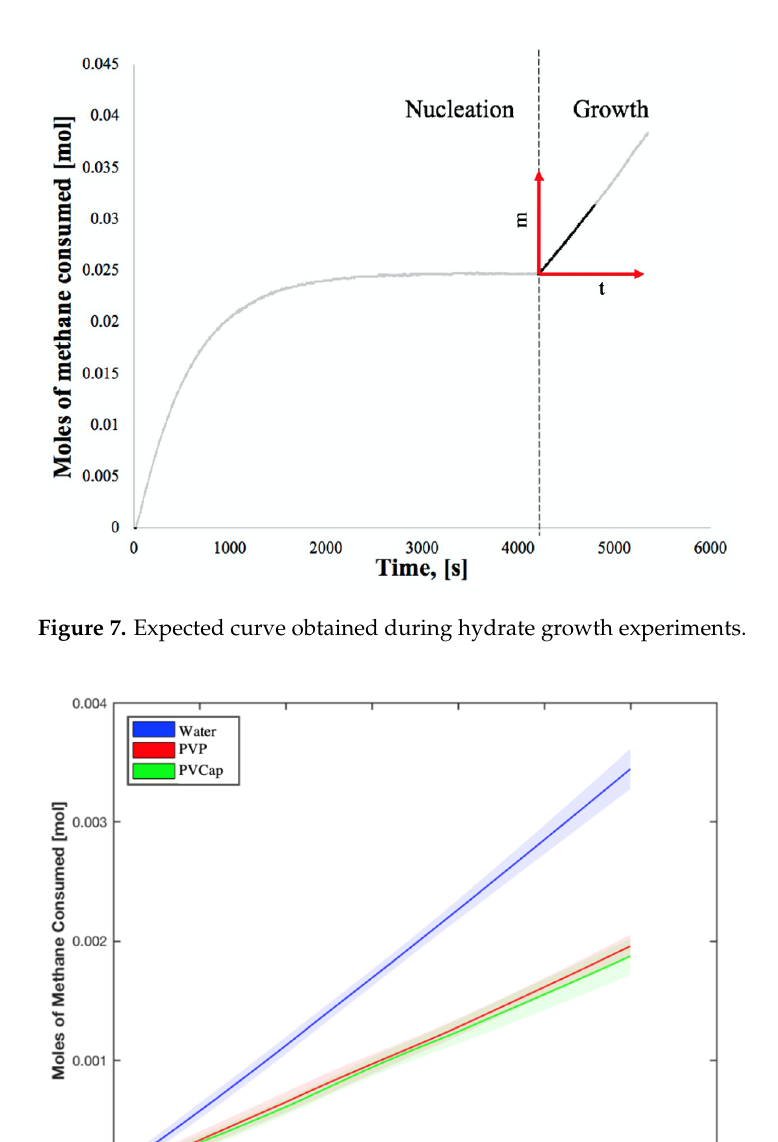
Figure 7. Expected curve obtained during hydrate growth experiments.